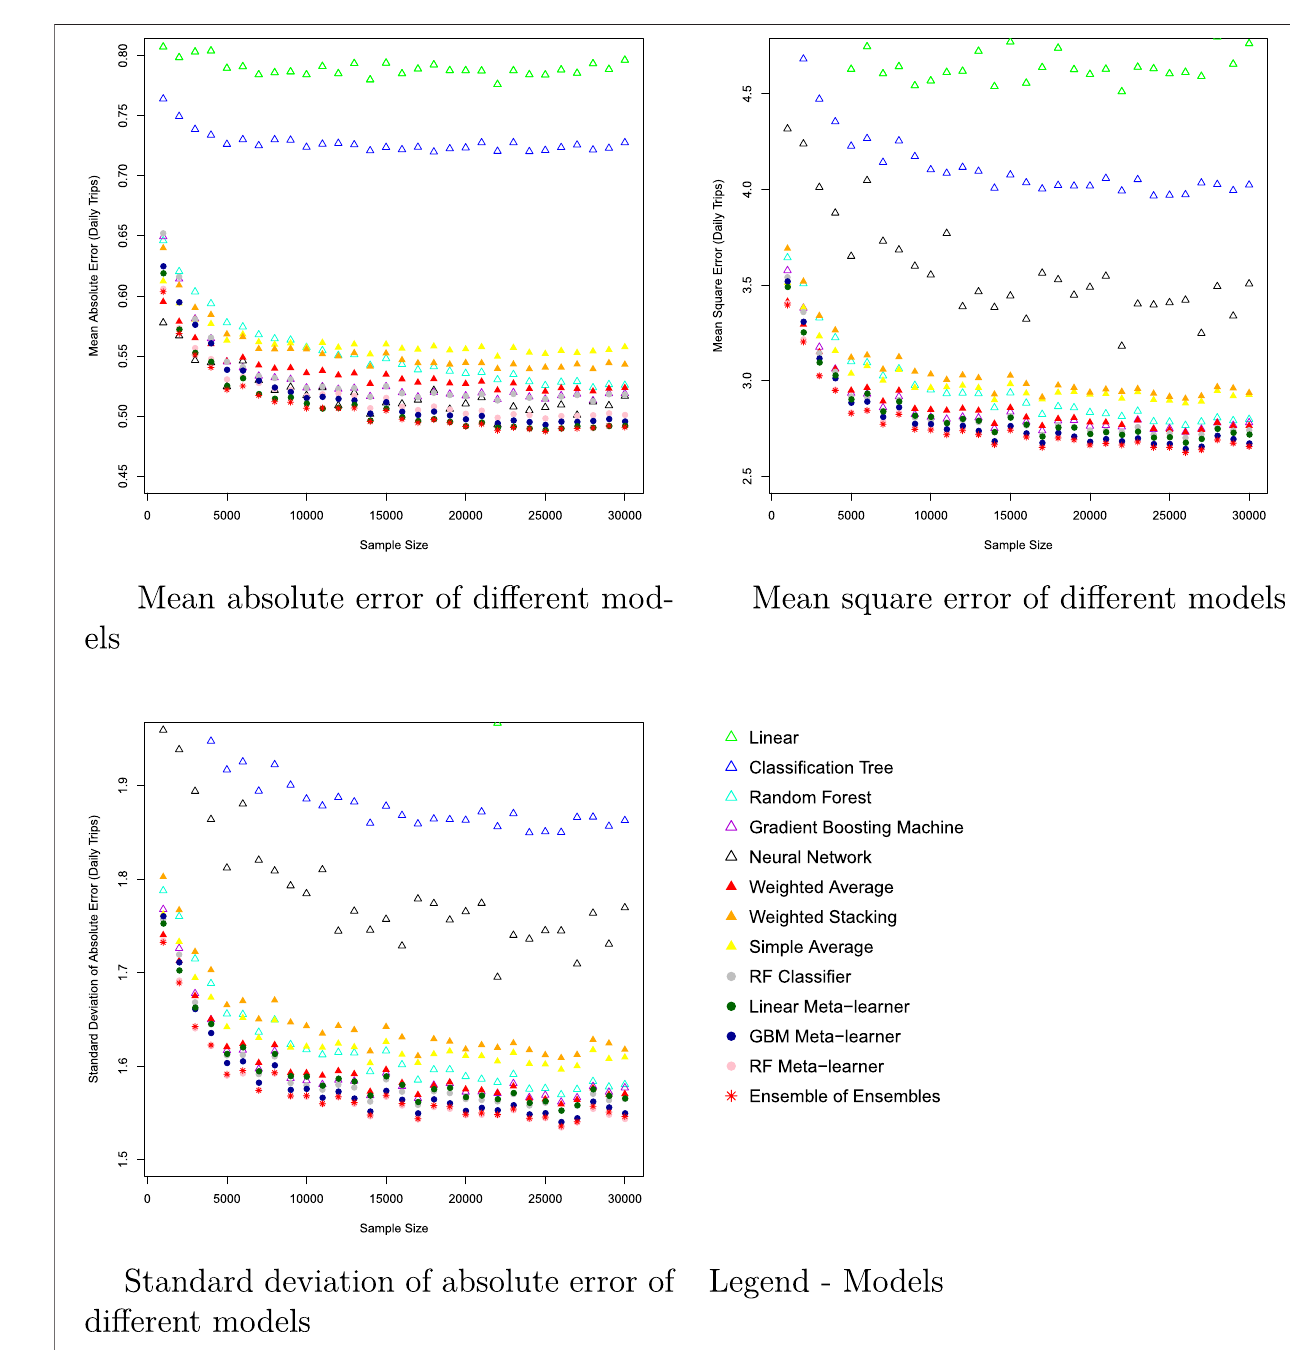
FIGURE 7 | Model performance in predicting Chicago FHV fl ow; Every dot is the average of 90 experiments, each with 100 testing samples.